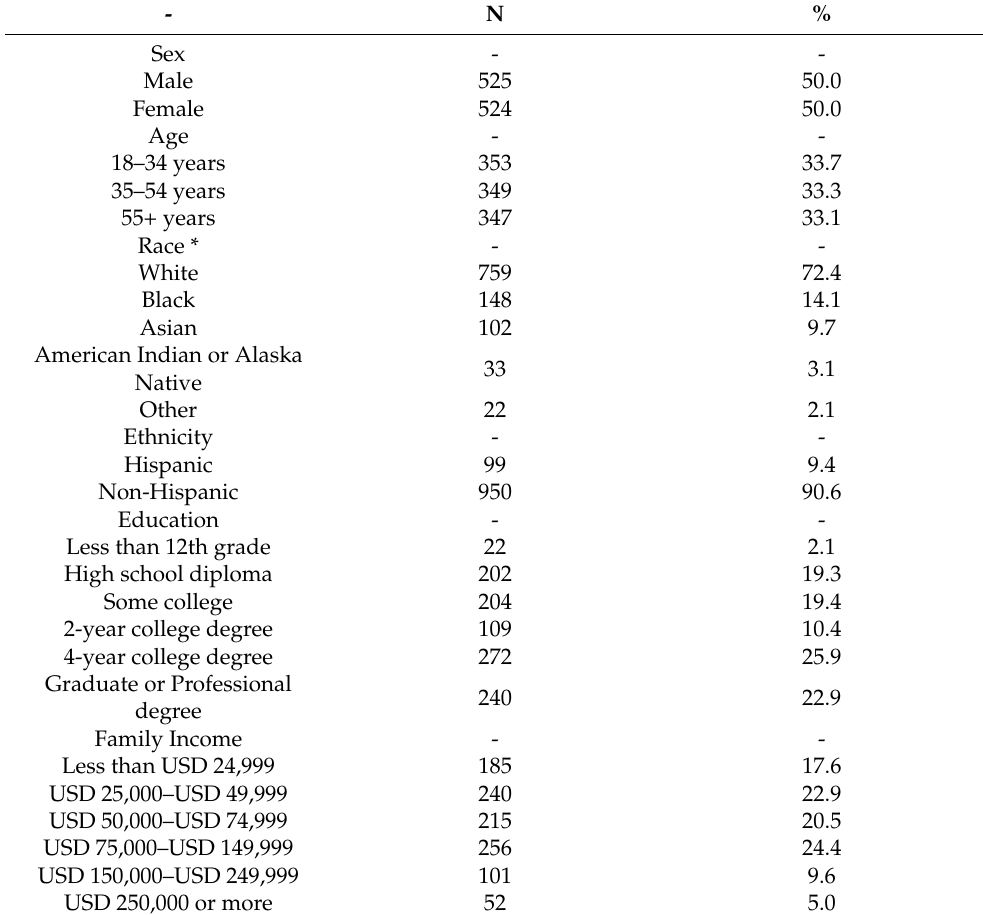
Table 1. Demographics of Respondents (N =